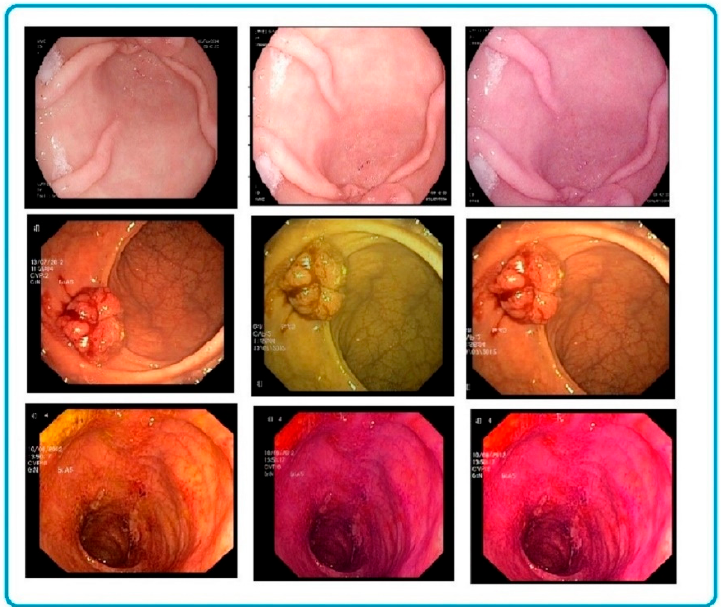
Figure 5. Data augmentation visualization for custom CNN models using random rotation, hue, and brightness. The left side consists of the original dataset, and data augmentation results from the second part of the table.